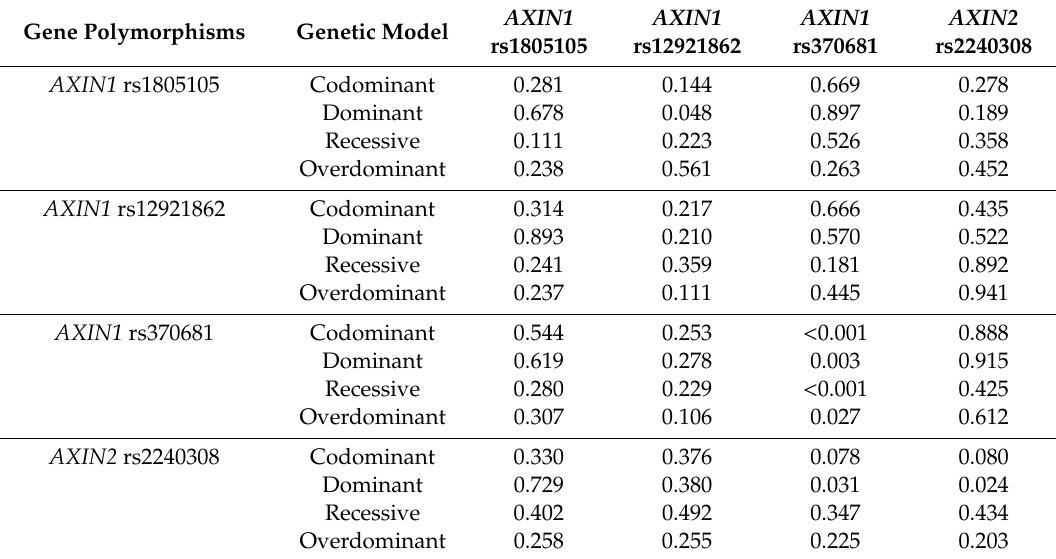
Table 5. Epistatic pairwise interactions between AXIN1 and AXIN2